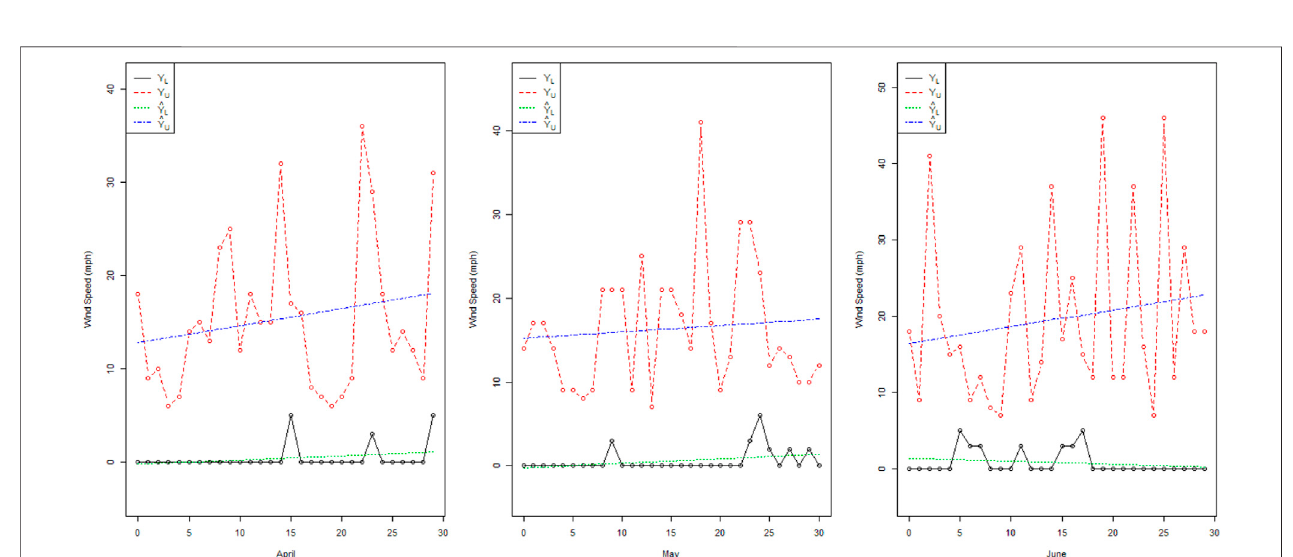
FIGURE 3 | Trended lines for April, May, and